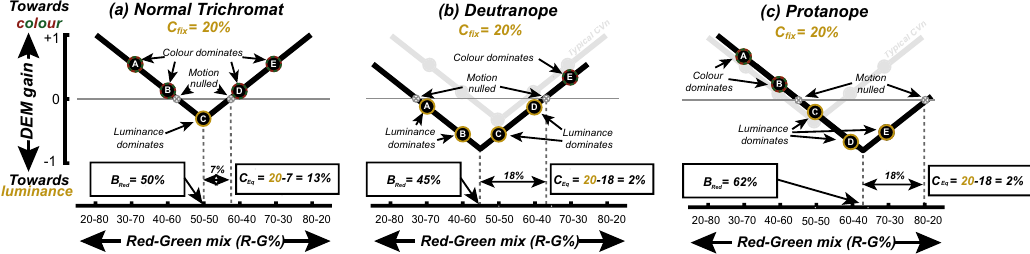
Figure 4. Schematic DEM gain response for ( a ) CVn, ( b ) CVd (deut) and ( c ) CVd (prot) participants viewing variable-contrast colour gratings in the presence of a fixed-contrast (20%) luminance grating. ( a ) Expected DEM-gain plot against red/green colour mix of the coloured grating. Points A and E show a strong positive response (in the direction of the coloured grating) when the colour mix is dominated by either red or green. When colour-mix leads to equi-brightness (point C; quantified as B Red ), DEM is poorly driven by the coloured grating and switches to the direction of the luminance-defined grating. At points marked ⊗ colour and luminance gratings elicit similar DEM in opposite directions, leading to motion nulling. ( b ) and ( c ) With a CVd (deut) and CVd (prot) observer the tip of the “V-function” is shifted horizontally relative to equiluminance (50–50); e.g. ( b ) leftwards for a deuteranope and ( c ) rightwards for a protanope. Boxed equations in ( b ) and ( c ) explain how equivalent luminance contrast ( C Eq ) is estimated from shifting of motion null-points caused (here) by the V-function shifting downwards (Video 2).